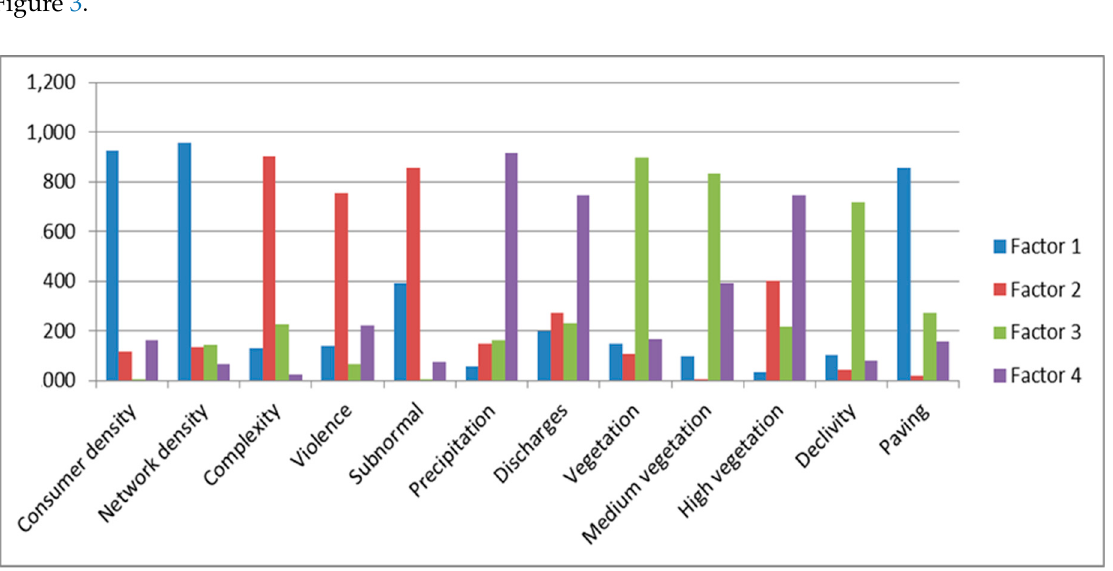
Figure 3. Participation of variables in each factor.